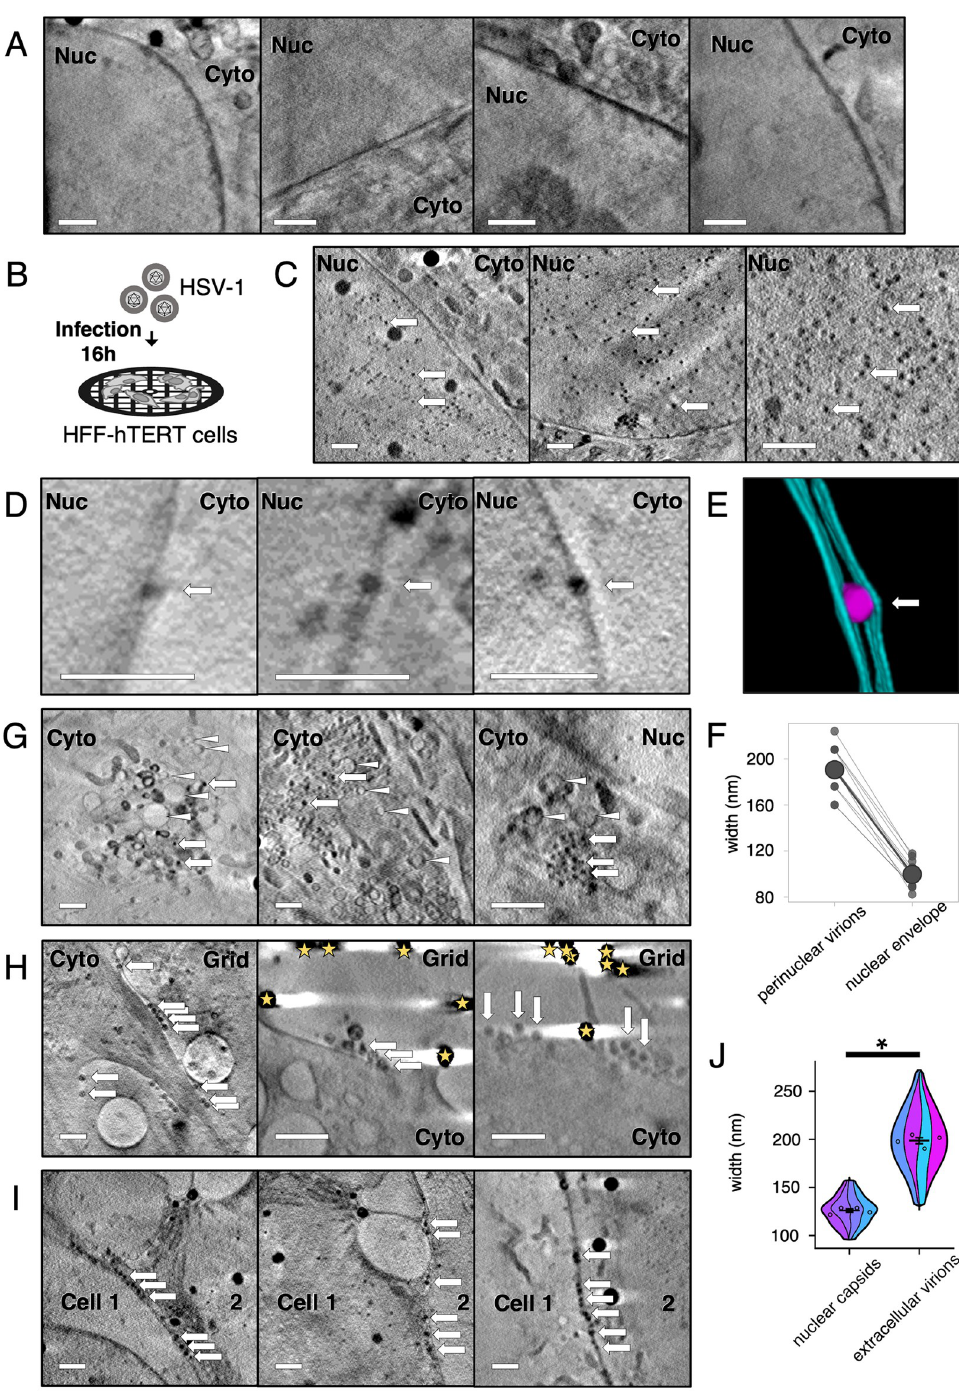
Fig 1. Soft X-ray tomography imaging at cryogenic temperatures of HSV-1-infected HFF-hTERT cells identifies virus particles. HFF-hTERT cells were grown on EM grids, infected (MOI 2) with HSV-1 or mock-infected, and plunge cryocooled 16 hpi. All tomograms were reconstructed from X-ray projections collected using 25 nm ( A ) or 40 nm ( C, D, G–I ) zone plate objectives; scale bars = 1 μ m. ( A ) The nucleus (Nuc) has a largely uniform X-ray absorbance in uninfected HFF-hTERT cells. Cyto, cytoplasm. ( B ) Schematic of infection workflow. ( C ) In HSV-1 infected cells many dark puncta are evident in the nucleus, consistent with these puncta being newly assembled HSV-1 capsids. ( D ) Dark puncta were also observed within the perinuclear space of the nuclear envelope, consistent with these being HSV-1 capsids undergoing primary envelopment/de-envelopment to leave the nuclear space. ( E ) Segmentation of a perinuclear viral particle